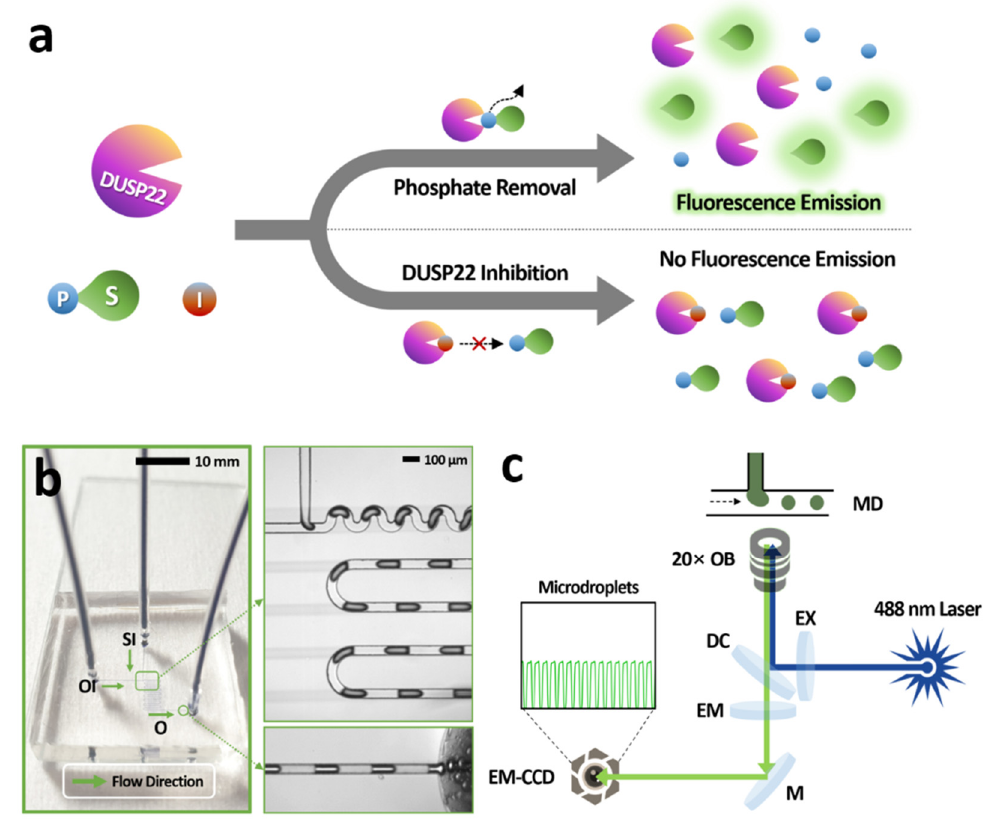
Figure 2. ( a ) Schematic representation of the working principle of phosphatase activity and inhibition assays (S, substrate; I, inhibitor; P, phosphate). ( b ) A droplet-based microfluidic chip with a simple T-junction structure was used for the analysis of DUSP22 activity. SI, sample inlet; OI, oil inlet; and O, outlet; Arrowhead, flow direction of liquid. ( c ) Optical setup for analyzing the fluorescence signal from microdroplets in a microfluidic channel (MD, microfluidic device; OB, objective; EX, excitation filter; DC, dichroic mirror; EM, emission filter; M, mirror; EM-CCD, electron multiplying-charge coupled device).